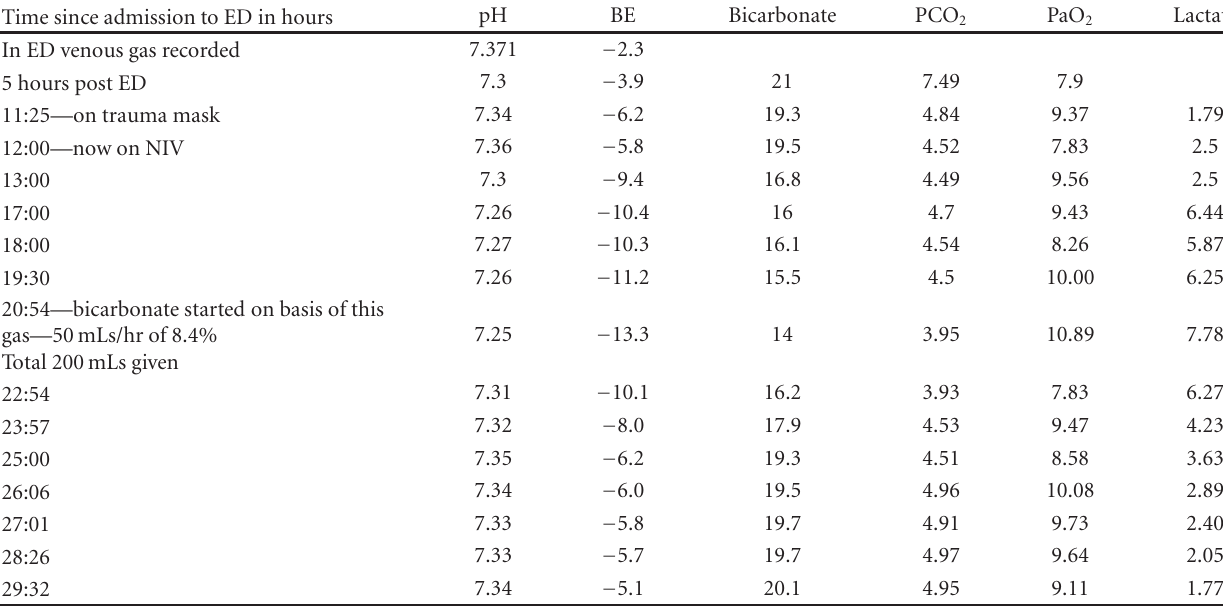
Table 2: Initial blood gas